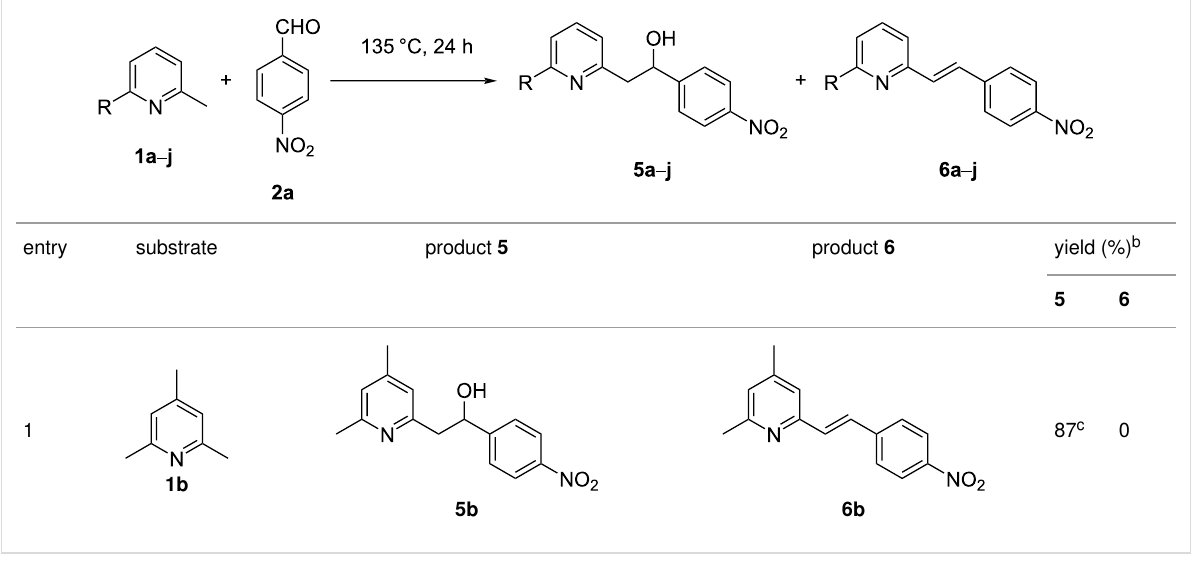
Table 3: Variation of the azaarene component 1 . a